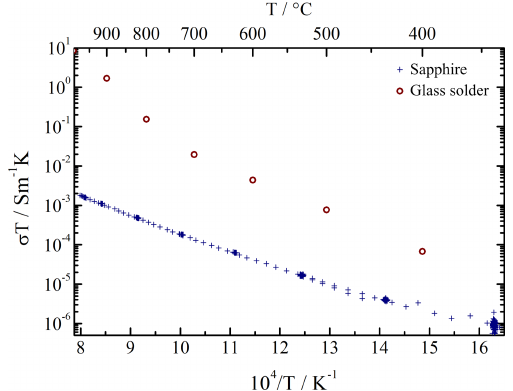
Figure 10. The conductivity of an Al 2 O 3 single crystal measured using the dielectric interface in conjunction with an impedance an- alyzer (crosses) and of the glass solder